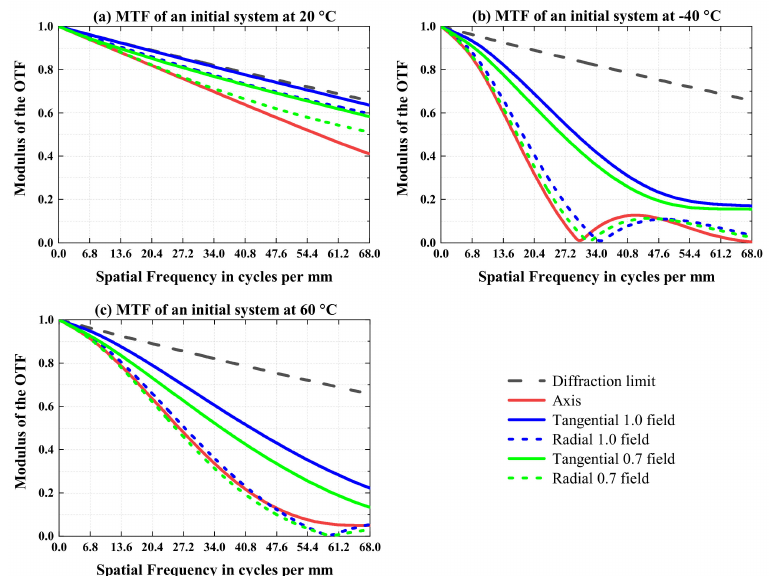
Figure 7. MTF performance of the initial optical system at temperatures of ( a ) 20 ◦ C, ( b ) − 40 ◦ C, and ( c ) 60 ◦